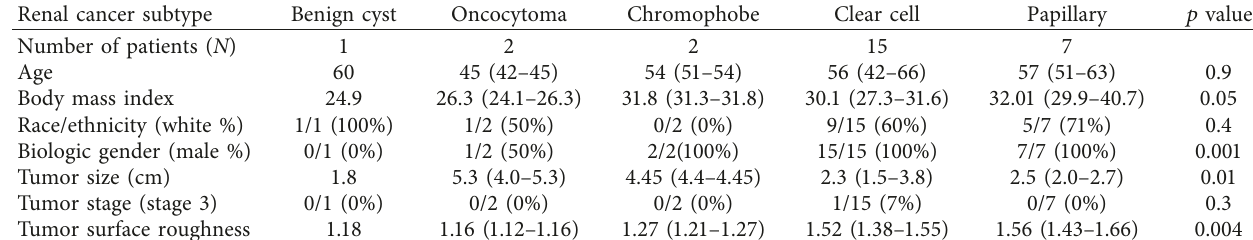
Table 1: Demographics by tumor